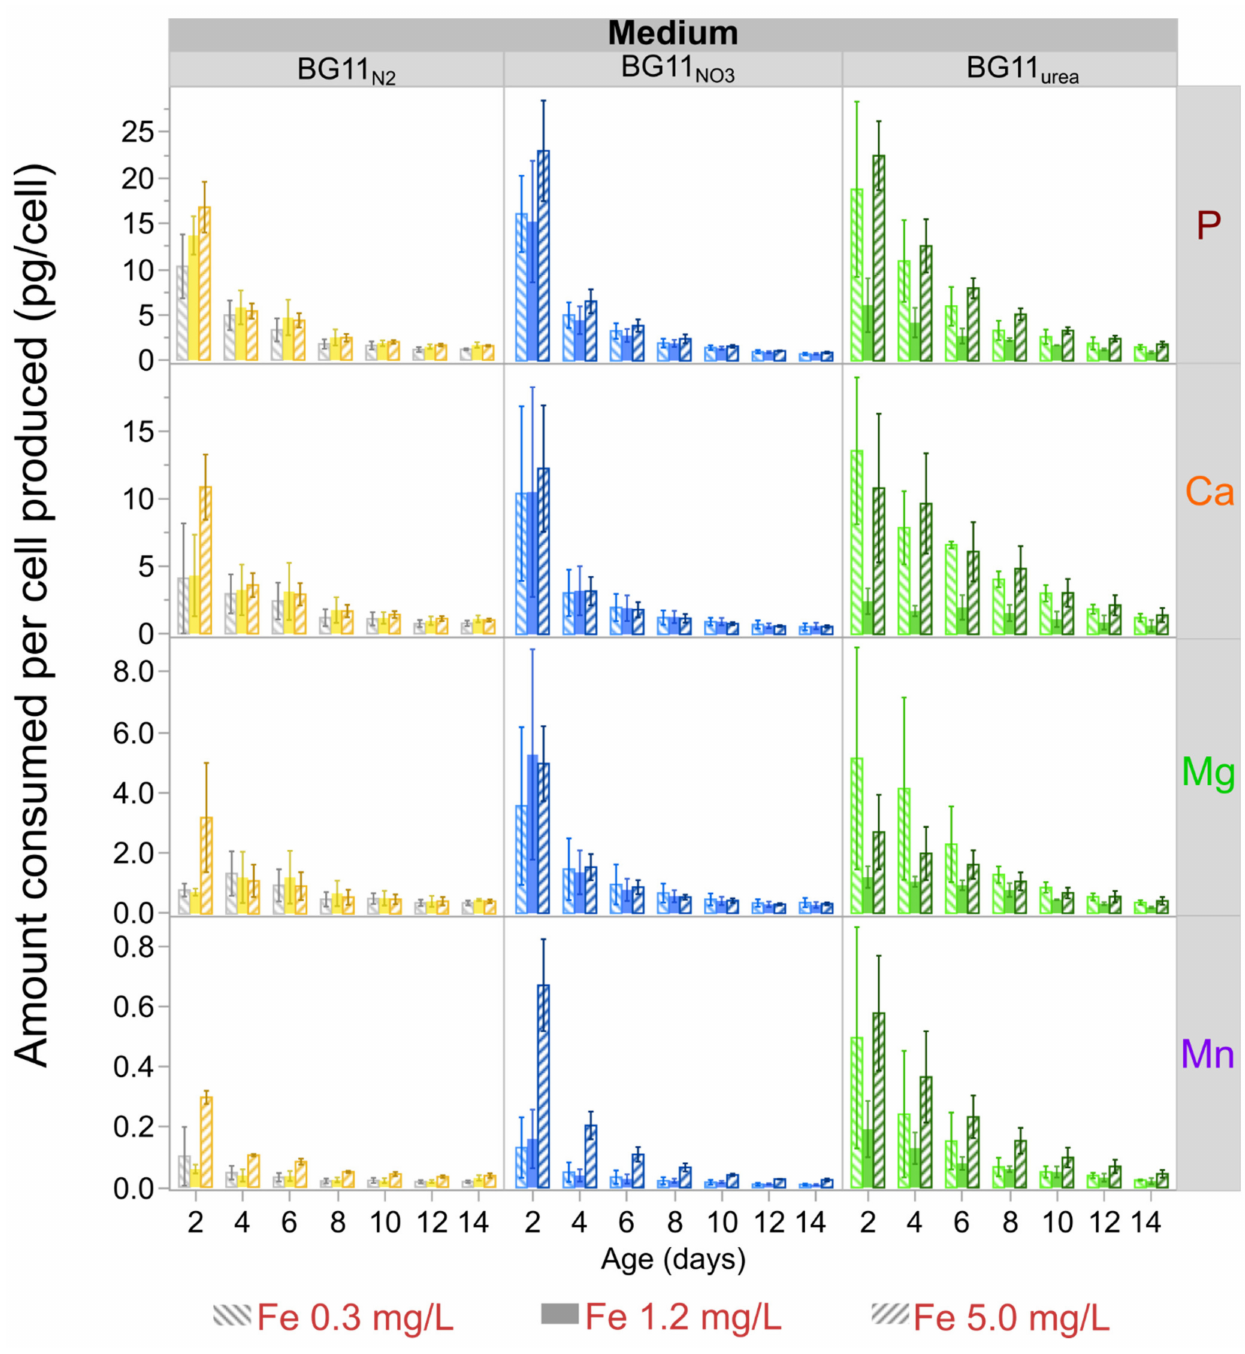
Figure 5. Consumption profiles of P, Ca, Mg and Mn per cell. The demand of these nutrient elements per cell is pronounced during the early stages of cellular growth. High initial Fe levels maximize the demand of P and Ca in all growth media. Low initial Fe levels increased Mg and Mn consumption in BG11 urea medium. High starting Fe levels also maximized the consumption of Mn in BG11 N2 and BG11 NO3 media, probably as a defense strategy against Fe promoted oxidation. Markers represent average values of three independent replicates and error bars are constructed using one standard error from the